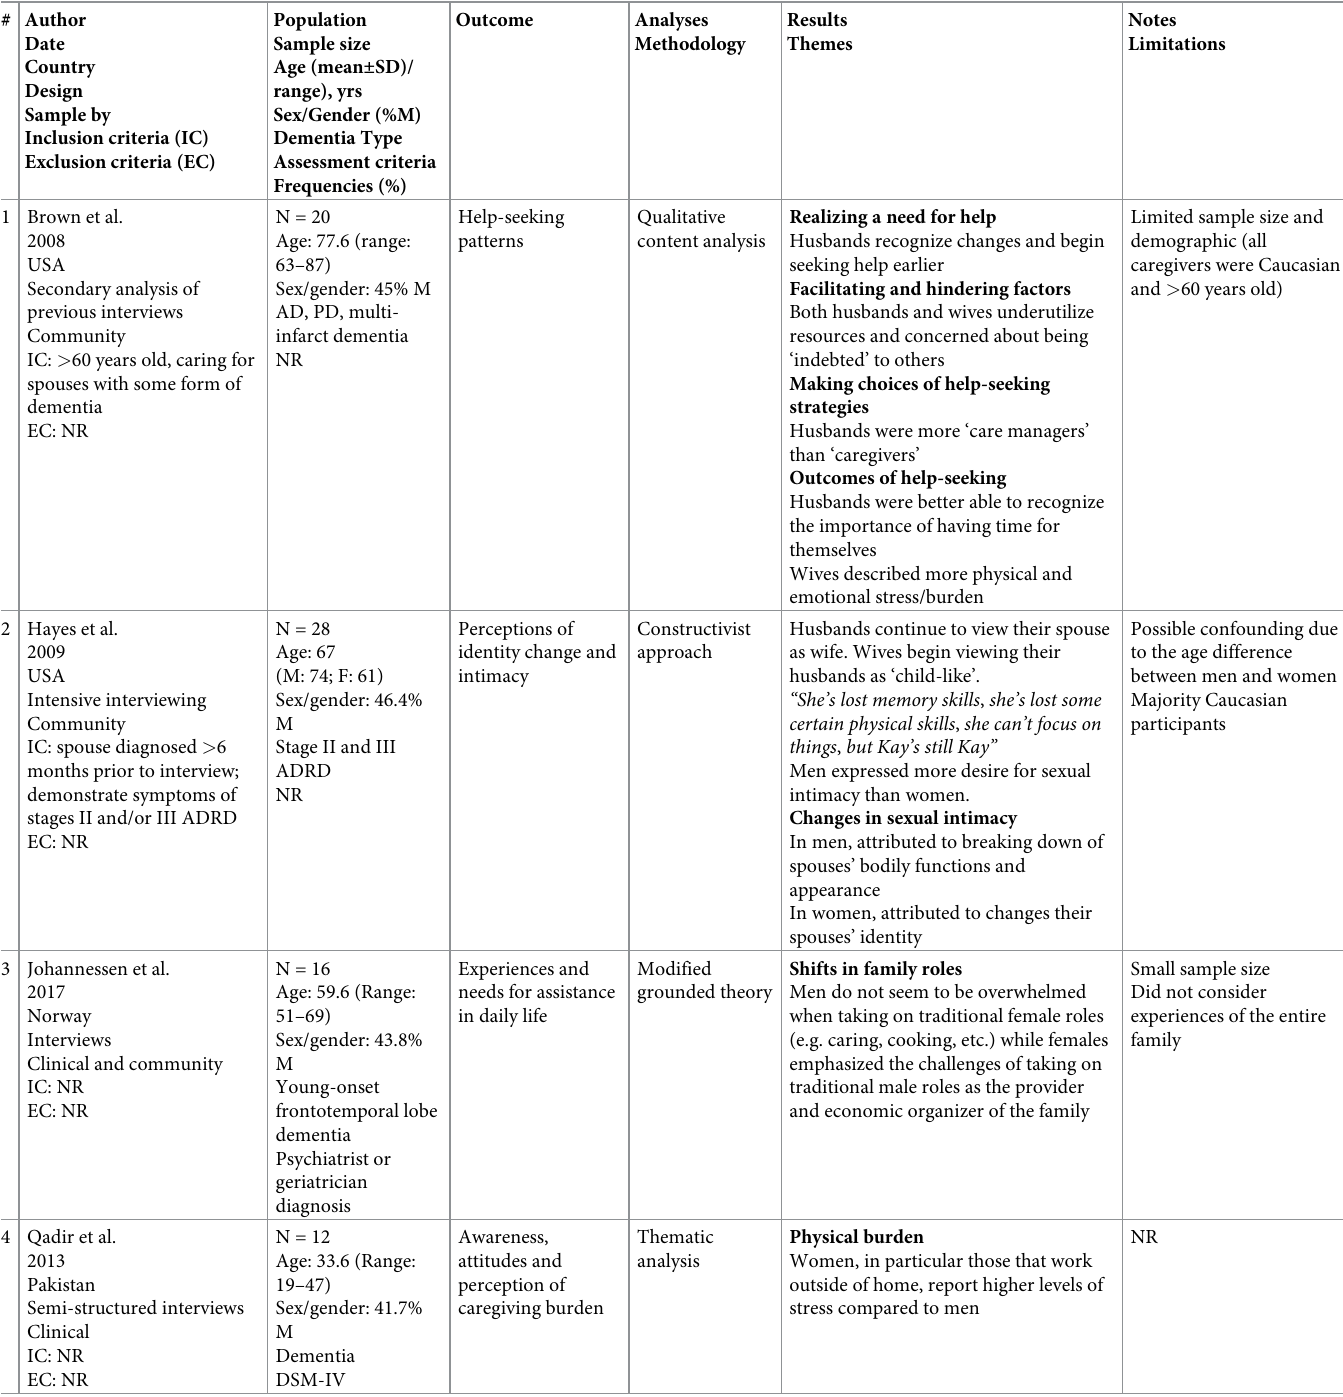
Table 2. Findings of all included qualitative